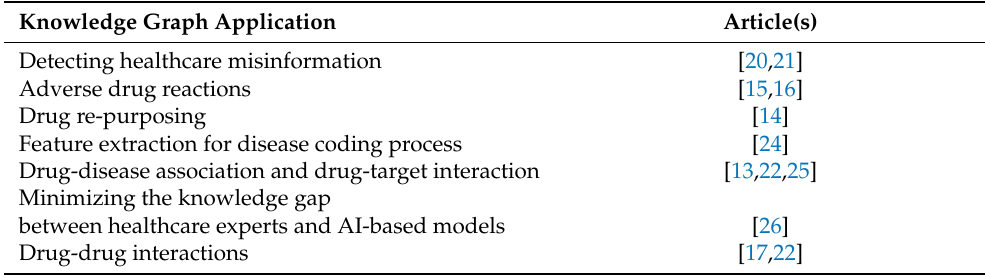
Table 1. Knowledge graph applications in Healthcare XAI in our literature